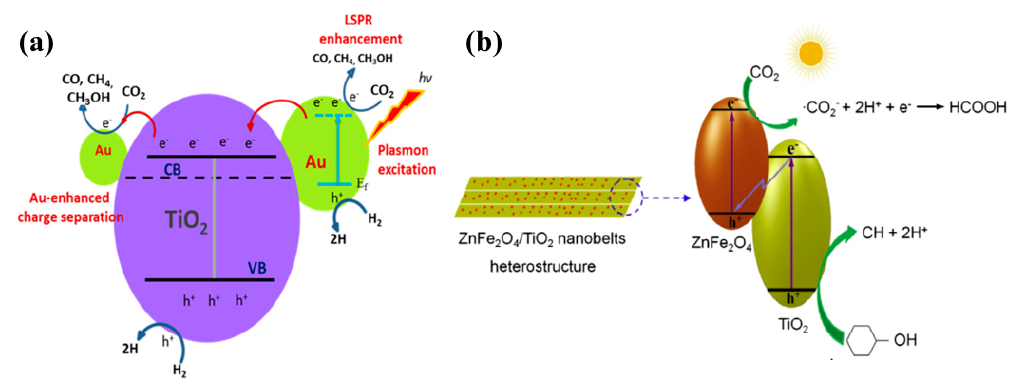
Figure 4. ( a ) Schematic presentation of the proposed photocatalytic conversion of CO 2 into CO, CH 4 , CH 3 OH and other value-added chemicals employing Au-TNW (taken with permission from [54]). ( b ) Z-scheme proposed for ZnFe 2 O 4 -TNB for CO 2 conversion to its respective products (taken with permission from [59]).